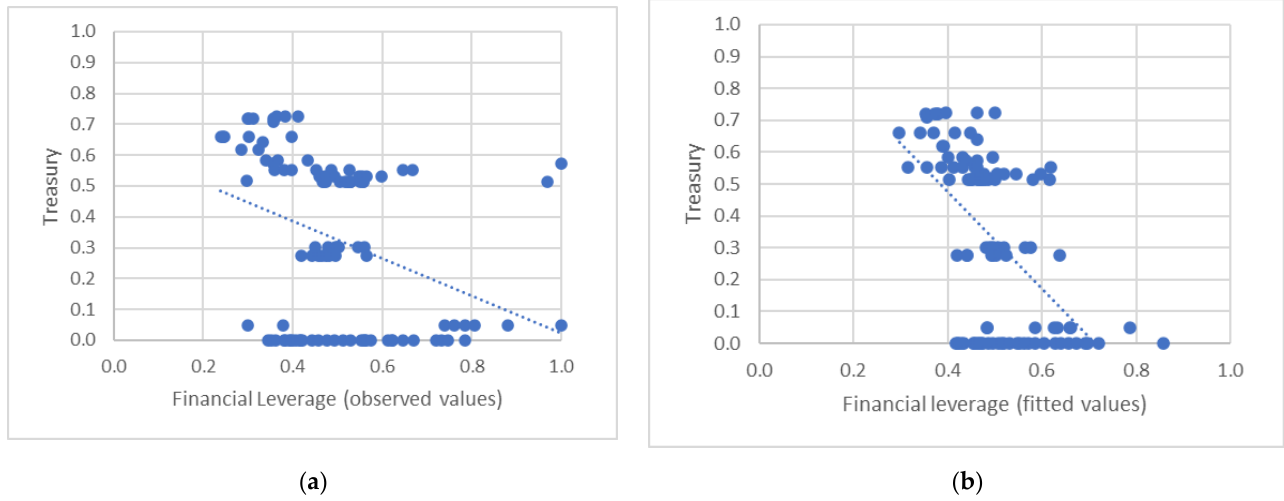
Figure 1. The figure presents financial leverage of the observed ( a ) and fitted ( b ) values in relation to the share of the state in the company’s shareholding. The trend line is added in both graphs.